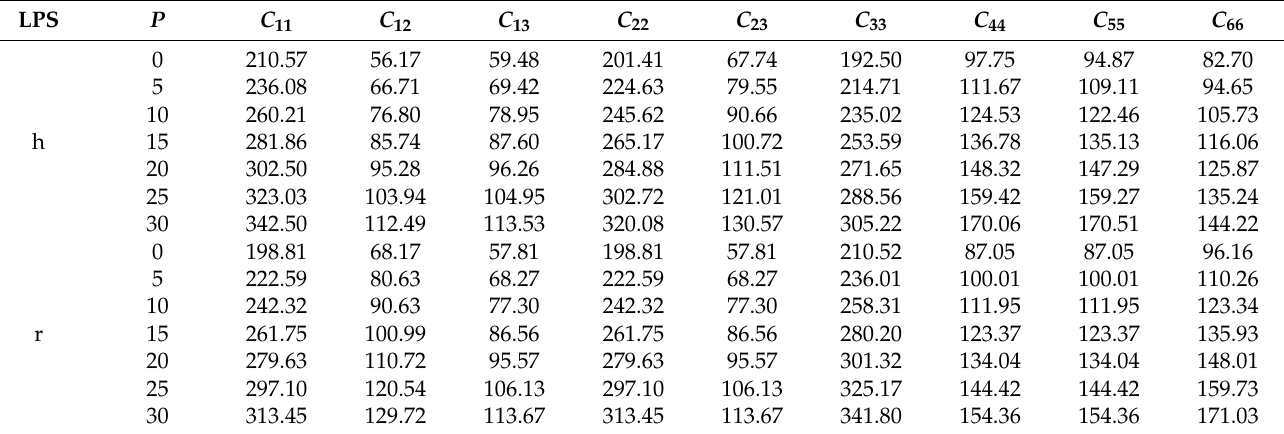
Table 3. Calculated elastic constants (in GPa) for the LPSs h- and r-Al 2 Ti under pressure up to 30 GPa at 0